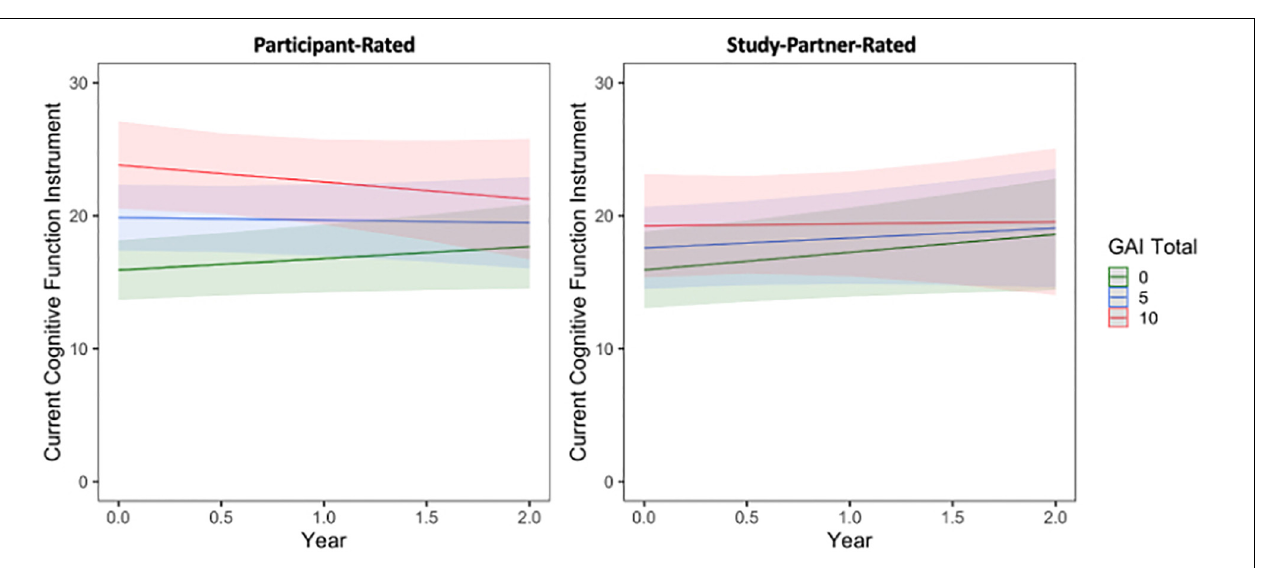
FIGURE 3 | The interaction between baseline participant GAI score and time to predict participant-rated (left) and study partner-rated (right) cognitive concerns using the current CFI. A significant interaction was seen between GAI score and time when predicting participant-rated cognitive concerns (fixed estimate = –0.19, adj. p = 0.0450), in that participant concerns decreased over time in participants with higher GAI score at baseline (indicative of greater anxiety symptoms). The interaction between GAI score and time predicting study partner-rated cognitive concerns was not significant (fixed estimate = –0.12, adj. p =